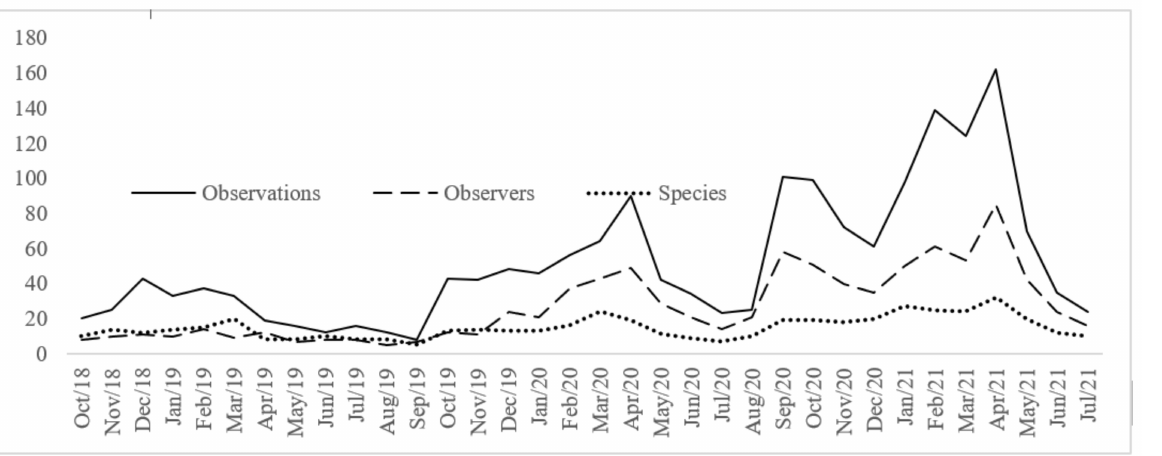
Figure 5. Time series of number of observations, species and observers in Australia, respectively, from October 2018 to July